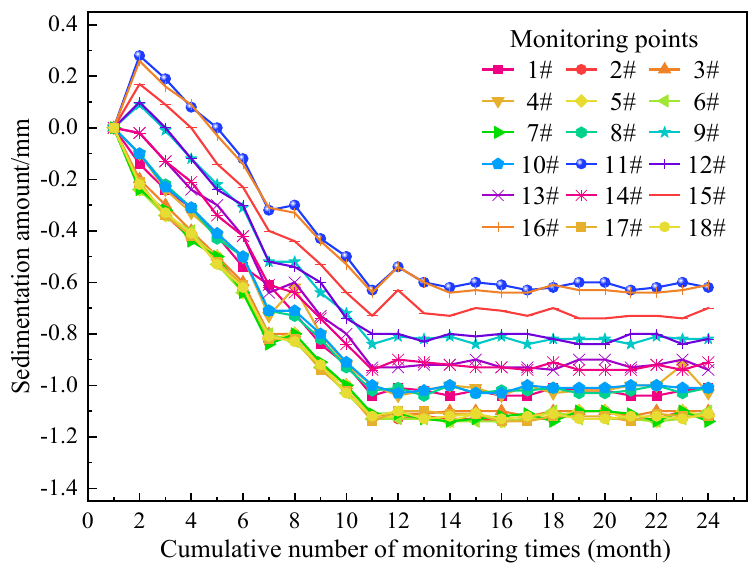
Figure 20. Perimeter pipeline monitoring diagram.